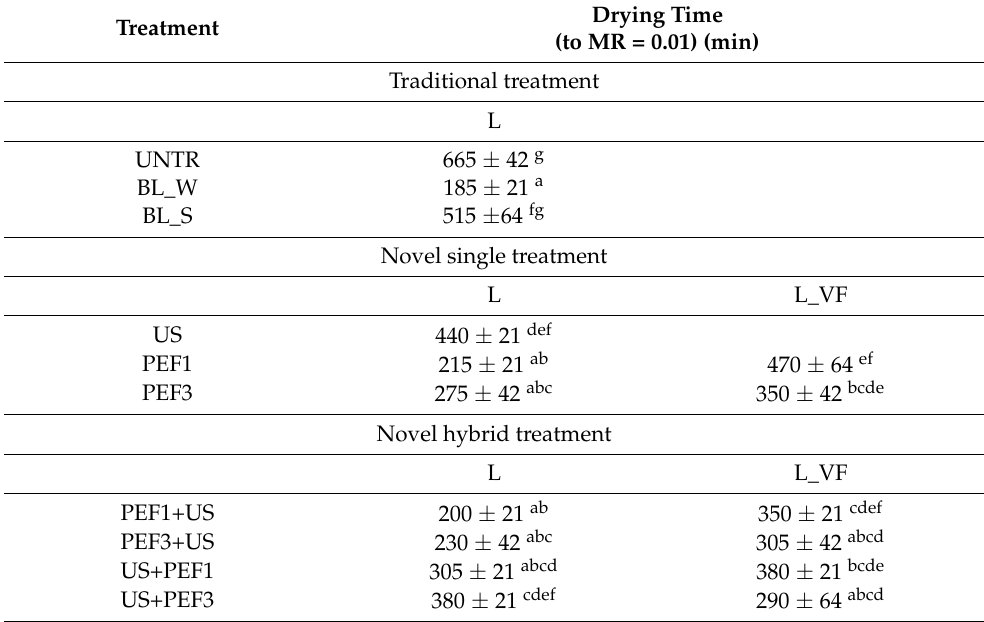
Table 2. Drying time (to moisture ratio (MR) equal 0.1) of freeze-dried red bell pepper preceded by shock freezing (L) and vacuum freezing (L_VF). Data are presented as a mean from 2 repetitions with a standard deviation (SD). Drying Time Treatment (to MR = 0.01) (min) Traditional treatment L UNTR 665 ± 42